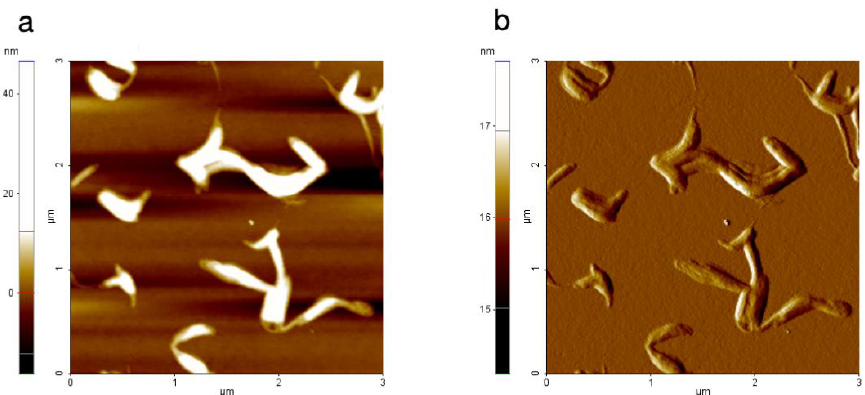
Figure 3. AFM image of AKV006 (DOPC) scanned at a location with “thicker” deposited lipid film, where ( a ) shows the topography data and ( b ) the amplitude signal ( c ) the phase signal, and ( d ) the topography profile for the two lines drawn in the topography image.